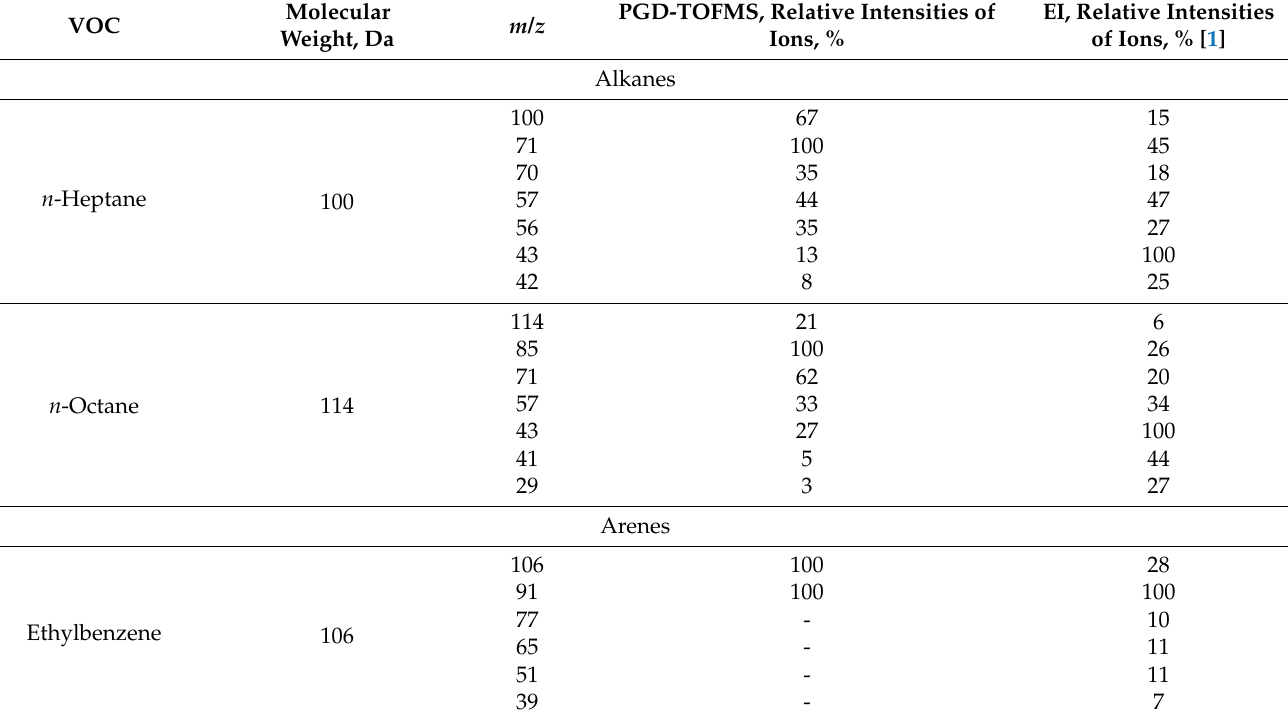
Table 1. Relative intensities of mass spectrometric components for different VOCs obtained in the current study by pulsed glow discharge time-of-flight mass spectrometry (PGD-TOFMS) and compared to 70 eV electron ionization (EI). For each compound, the highest intensity fragment is taken as